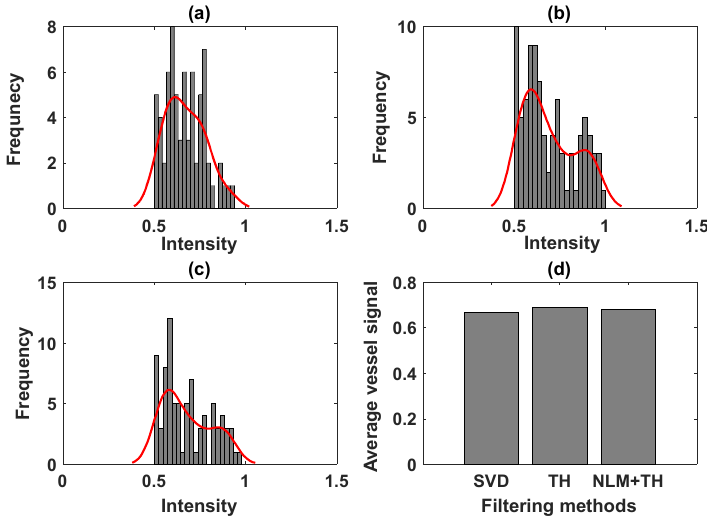
Figure 5. The intensity histogram comparison of vessel signal using ( a ) gross unbiased SVD, ( b ) SVD+TH, and ( c ) proposed method (NLM+TH); ( d ) average vessel signal of the gross unbiased SVD, SVD+TH, and proposed method (NLM+TH).